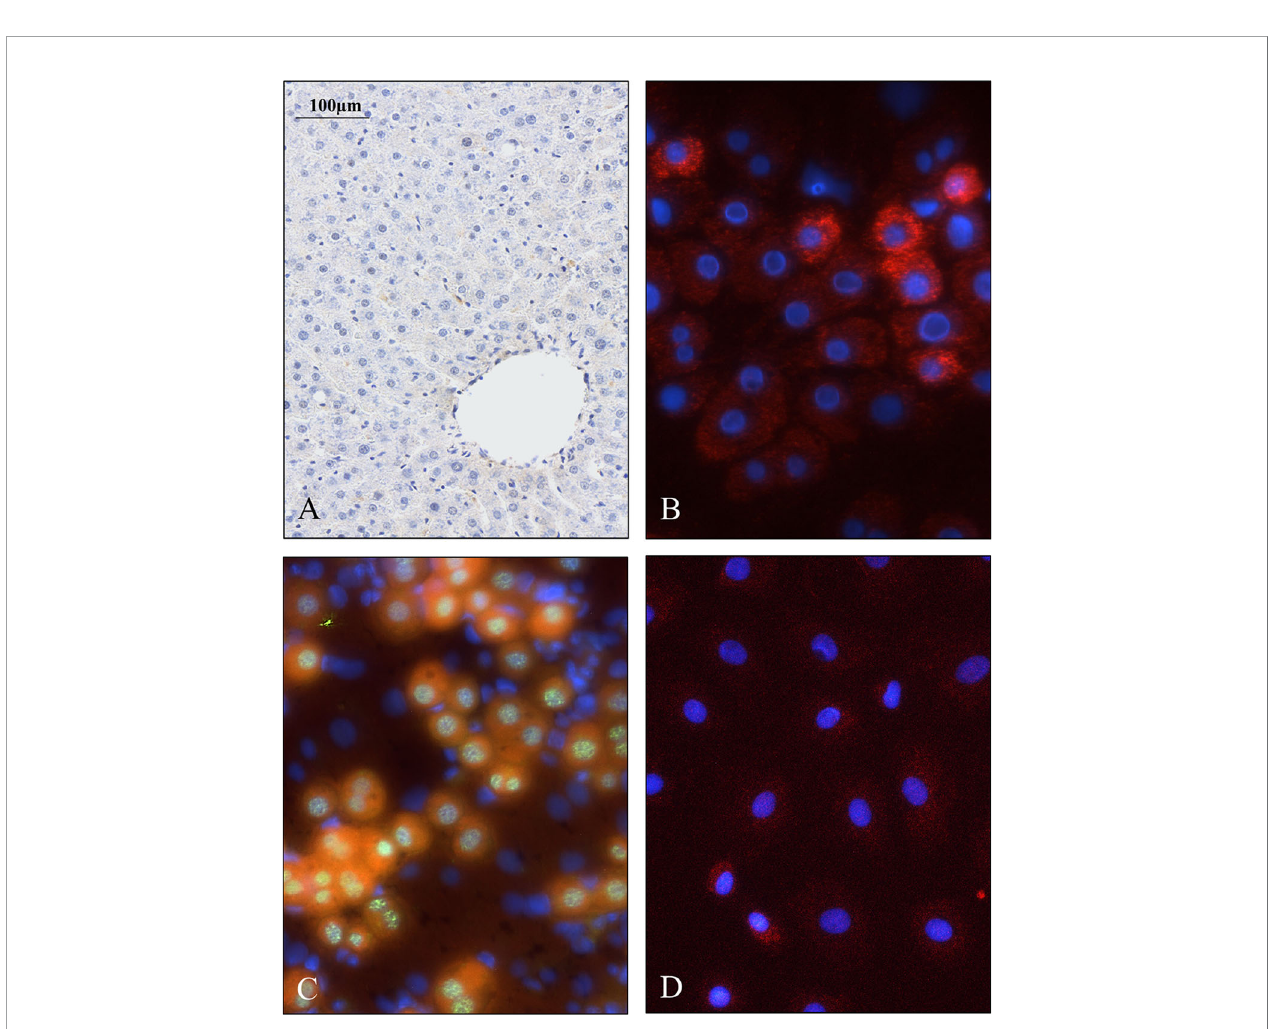
FIGURE 5 | Weak SPOCK1 staining in healthy rat liver, fast upregulation of SPOCK1 during hepatocyte isolation. (A) SPOCK1 protein cannot be detected in healthy rat liver. (B, C) Upregulation of SPOCK1 as a function of time in isolated hepatocytes. (C) HNF4 a (Hepatocyte Nuclear Factor 4 Alpha ) can be detected in the nucleus. (D) After 3 days of culture, the proteoglycan expression returns to the original low